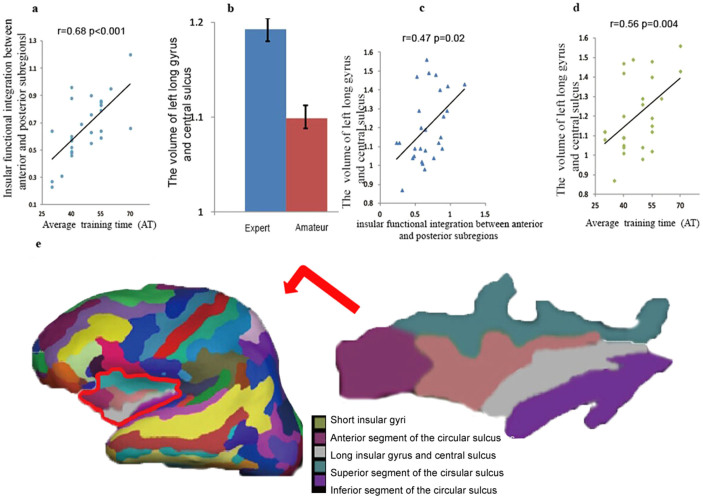
Correlation and GMV subregion analysis.2a, 2b and 2c are pairwise Pearson correlations that include insular functional integration, GMV and the average playing time. 2d is a comparison between the two groups within the left long insular gyrus and central sulcus. 2e illustrates an inflated surface of the left hemisphere. The long insular gyrus and central sulcus is shown in grey and is located near the transitional subregion.